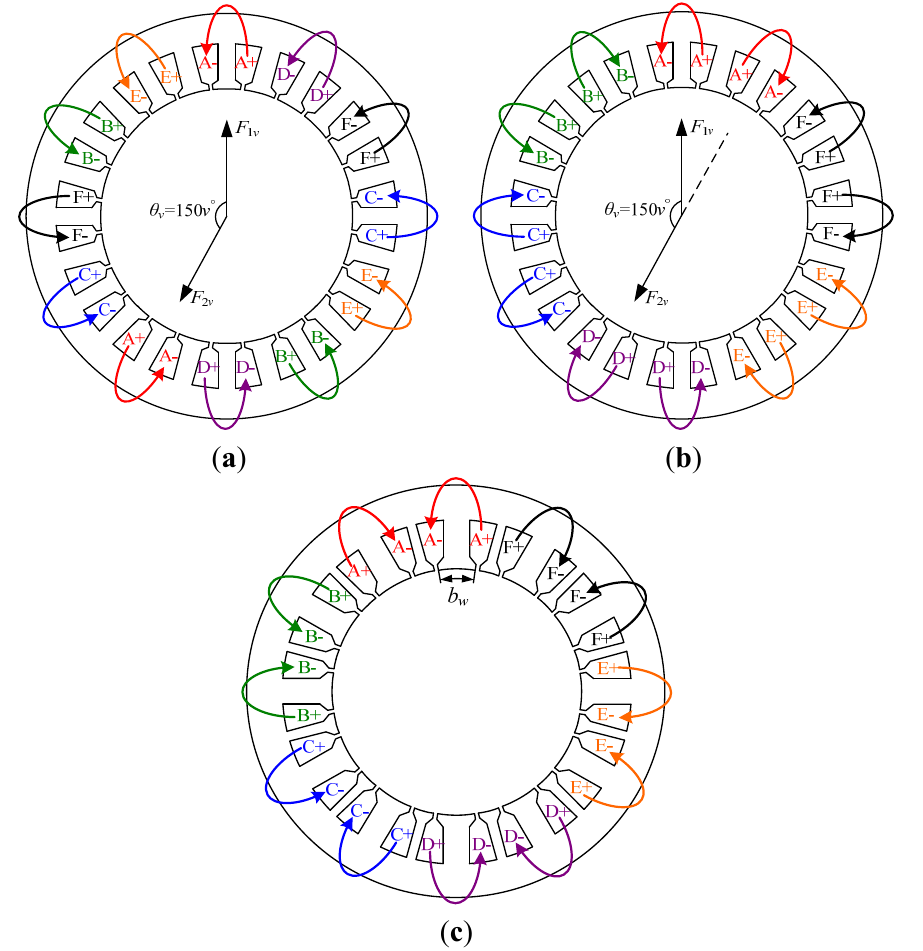
Figure 4. Stator winding arrangements of the 24-slot alternate-teeth-wound six-phase PMSM: ( a ) two coils of same phase shifting by 150 degree; ( b ) two adjacent coils per phase; and ( c ) two adjacent coils per phase with unequal teeth widths.